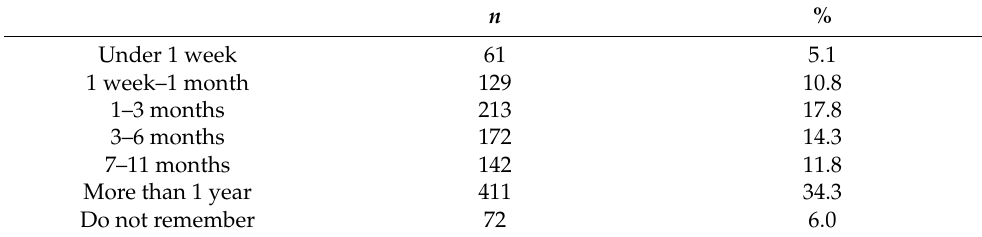
Table 10. Duration of estrogen-like supplement use.